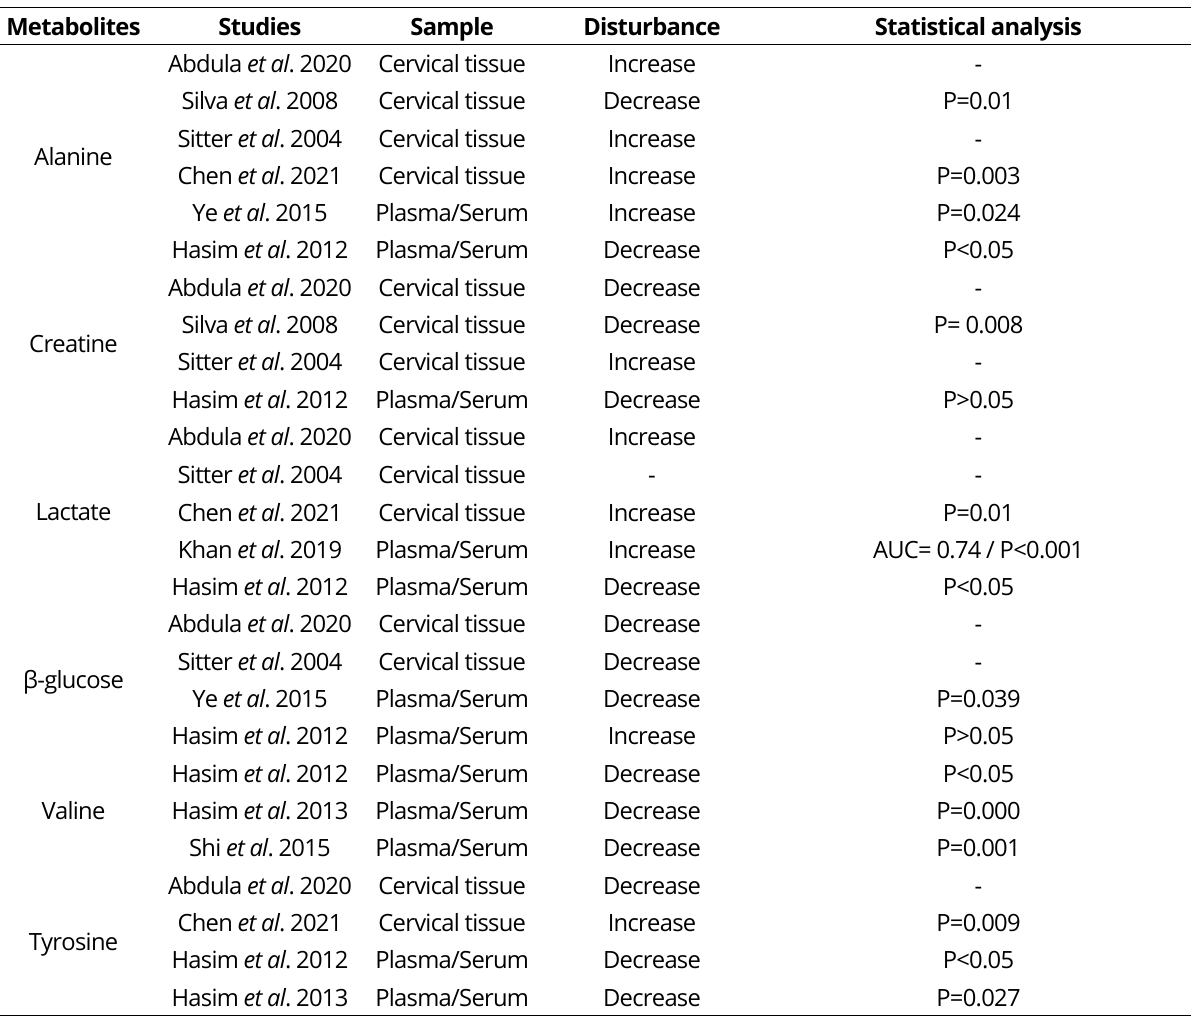
Table 3 - Metabolites found in common in selected